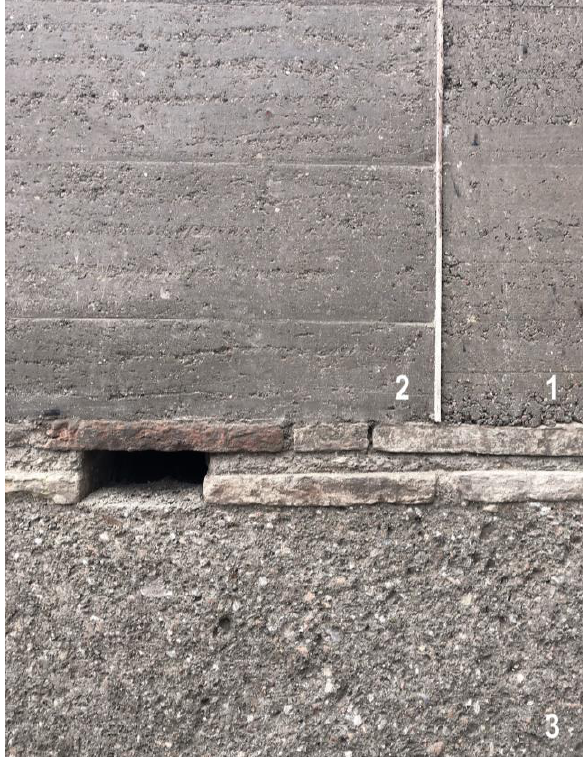
Table 2. Surface finishes in west wall of the Bañuelo.